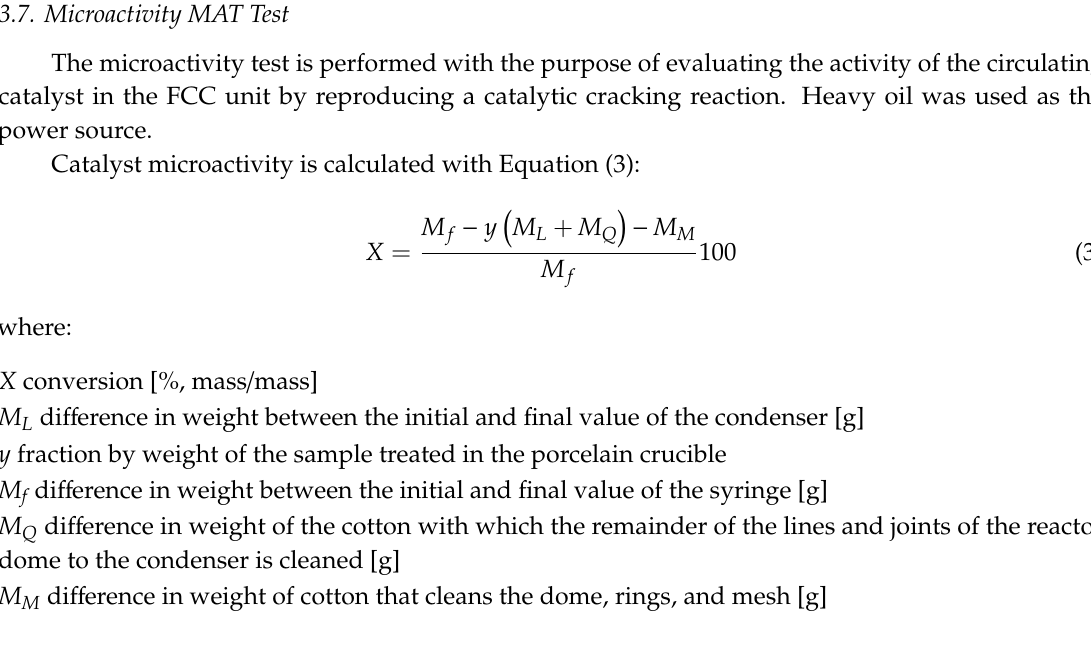
Table 20. Conversion (X) evaluated through the Micro Activity Test and TCE of the Equilibrium Catalyst (ECat), (RESIDCAT ® R 137).